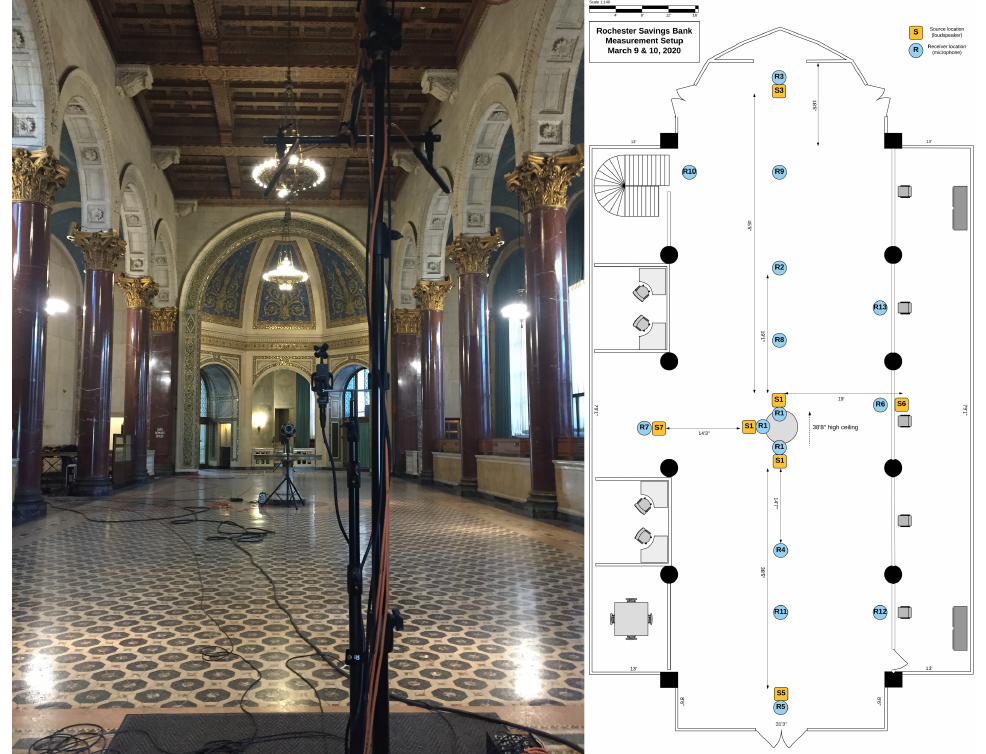
Figure 2. Rochester Savings Bank (Rochester, NY, USA): photo and schematic of aural heritage fieldwork configurations showing multiple acoustical source and receiver locations, iteratively measured using a variety of equipment and microphone configurations. Diagram by Doyuen